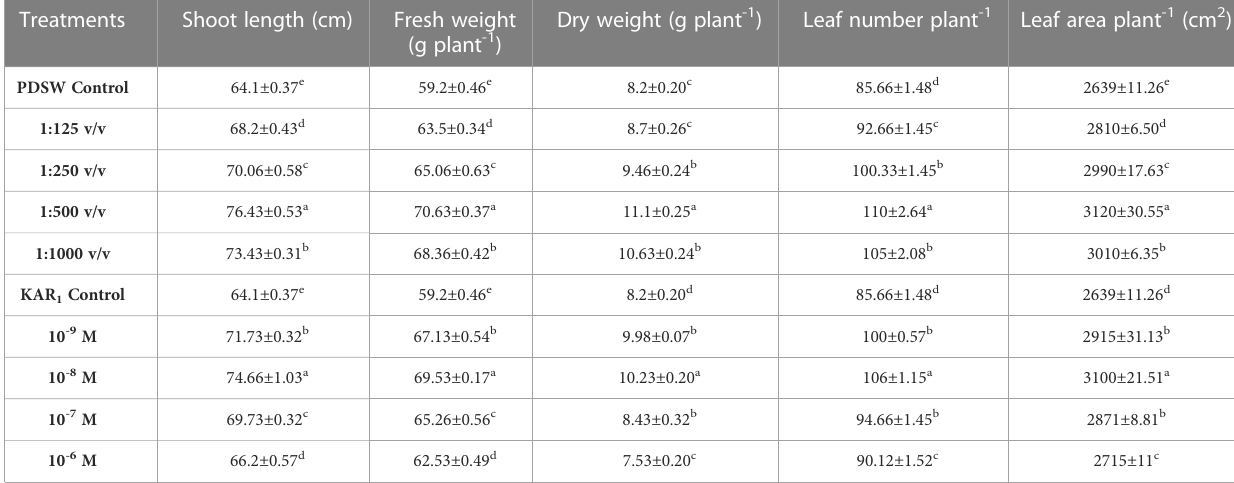
TABLE 1 Effect of foliar application with PDSW and KAR1 on shoot height, fresh weight, dry weight, leaf number and leaf area per plant of Mentha arvensis L. recorded at 90 DAP (days after plantation).